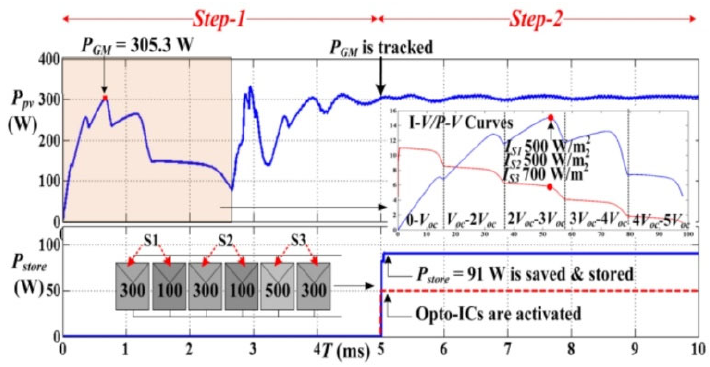
Figure 12 . Case 3: extra power of 91 W is stored by the proposed hardware scheme .